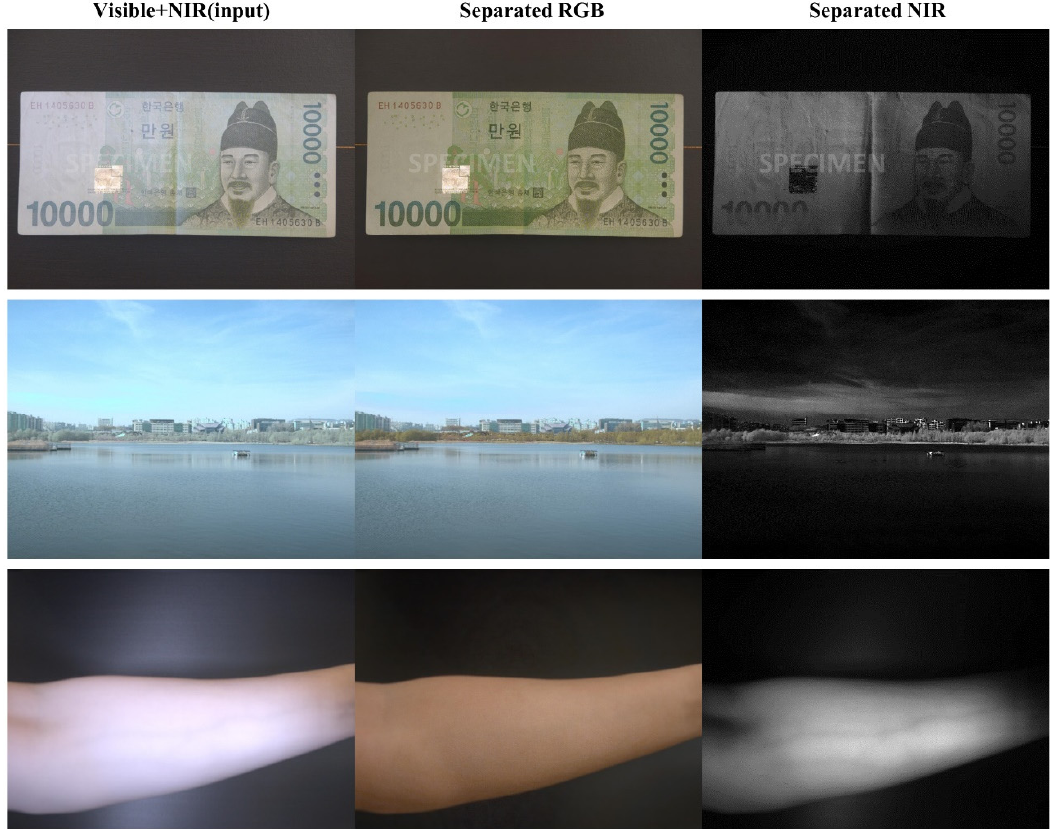
Figure 8. Examples of potential applications of the proposed method (Note: “SPECIMEN” text at banknote is overlapped on the images).